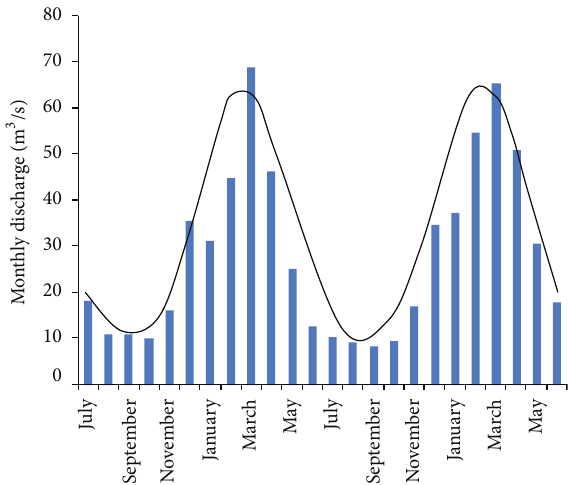
Figure 4: Fitted second harmonic on discharge in El Nino event years at Chamriz station.